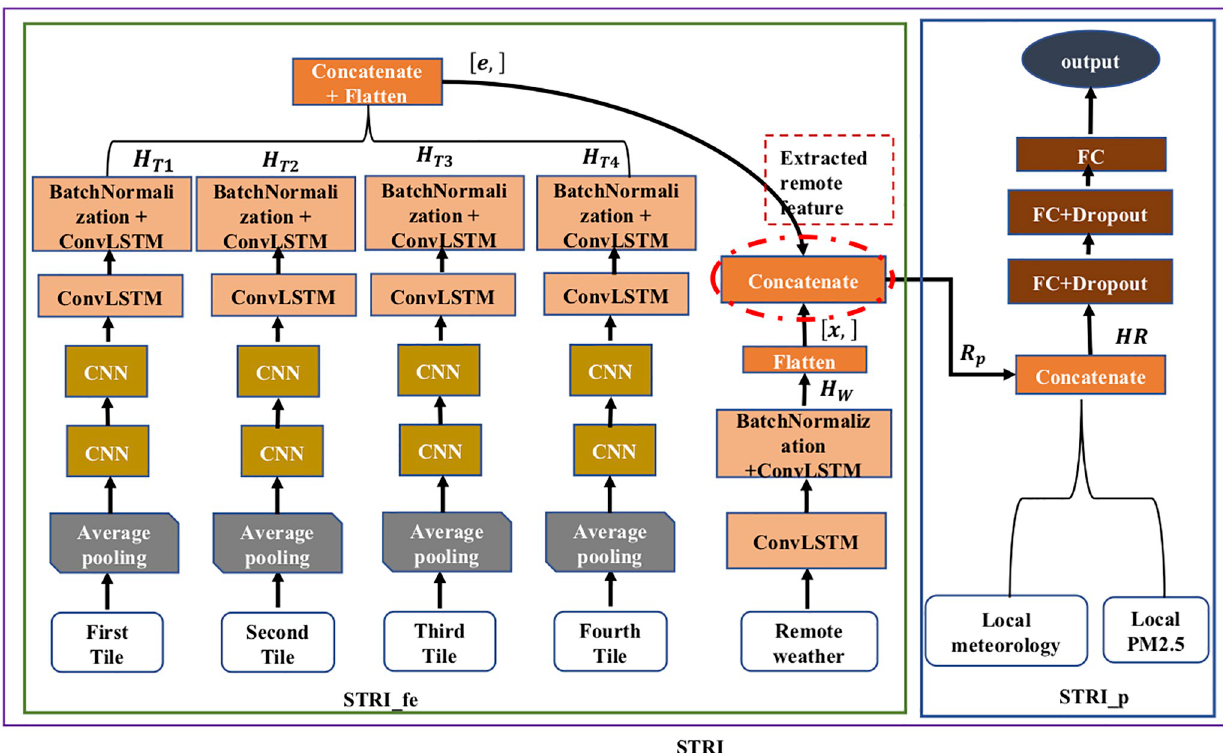
Fig 2. STRI model. Structure of STRI, STRI_fe and STRI_p models, where red dashed circle denotes extraction of spatio-temporal features from remote areas.